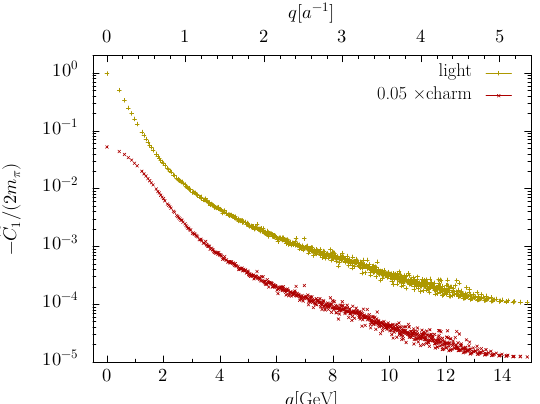
Figure 16. The Fourier transform of the correlator C 1 ( ~y ), evaluated using (5.14). The values for charm quarks are scaled by 0 : 05 for the sake of clarity. Statistical uncertainties on the data points are not visible at this scale. We divide the Fourier transform by